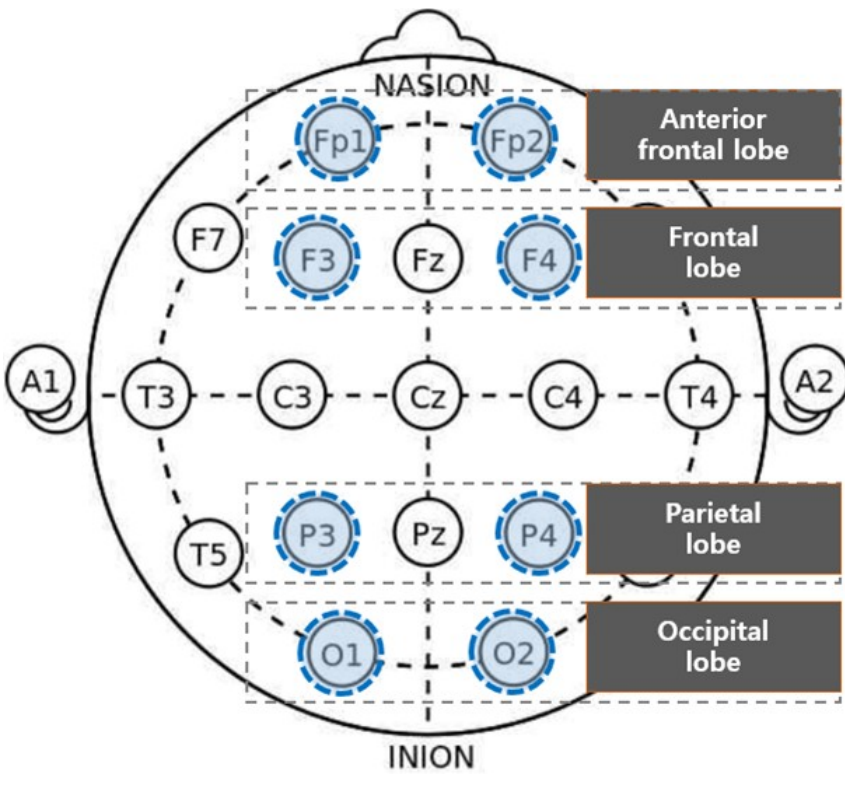
Figure 7. Brain wave measuring area.